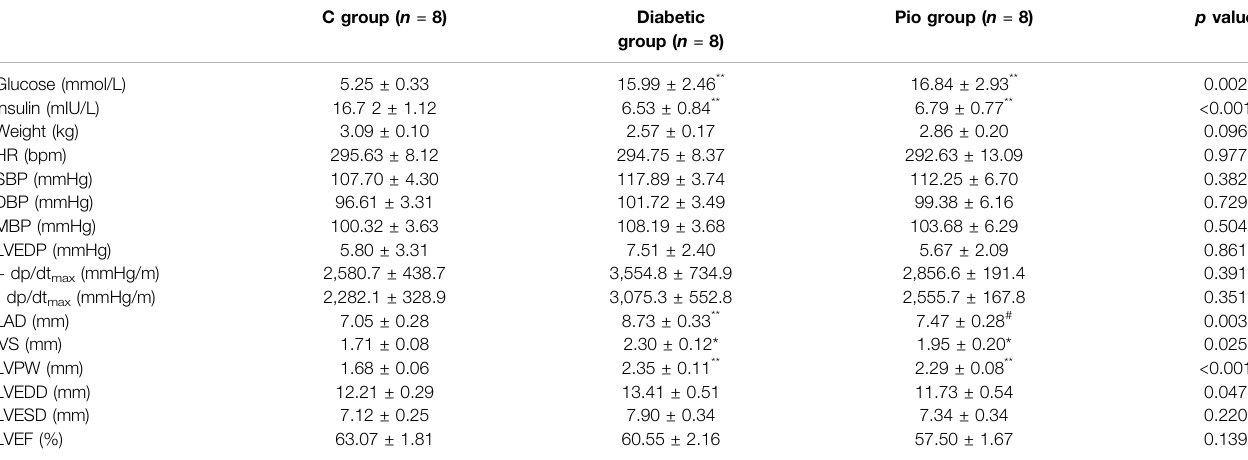
TABLE 1 | Metabolic, hemodynamic, and echocardiographic parameters of the control group (C group), diabetic group (Diabetic group), and pioglitazone-treated diabetic group (Pio group).